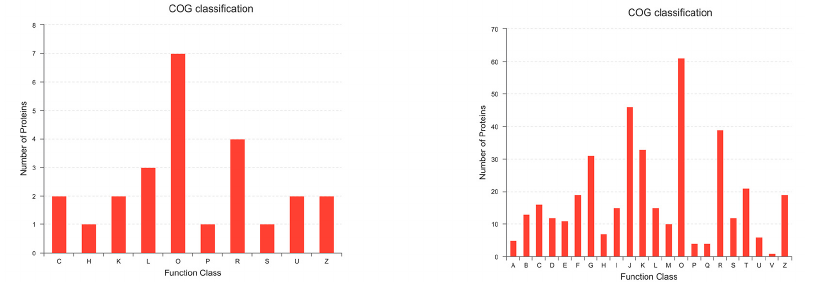
Figure 6. The COG annotation of significantly upregulated proteins ( left panel ) and downregulated proteins ( right panel ). The x ‐ axis indicates the COG functional classification (presented with A to Z): (A) RNA processing and modification; (B) Chromatin structure and dynamics; (C) Energy production and conversion; (D) Cell cycle control, cell division, and chromosome partitioning; (E) Amino acid transport and metabolism; (F) Nucleotide transport and metabolism; (G) Carbohydrate transport and metabolism; (H) Coenzyme transport and metabolism; (I) Lipid transport and metabolism; (J) Translation, ribosomal structure, and biogenesis; (K) Transcription; (L) Replication, recombination, and repair; (M) Cell wall/membrane/envelope biogenesis; (N) Cell motility; (O) Posttranslational modification, protein turnover, and chaperones; (P) Inorganic ion transport and metabolism; (Q) Secondary metabolites biosynthesis, transport, and catabolism; (R) General function prediction only; (S) Function unknown; (T) Signal transduction mechanisms; (U) Intracellular trafficking, secretion, and vesicular transport; (V) Defense mechanisms; (W) Extracellular structures; (Y) Nuclear structure; (Z) Cytoskeleton. The y ‐ axis indicates the protein number of particular functional classifications.